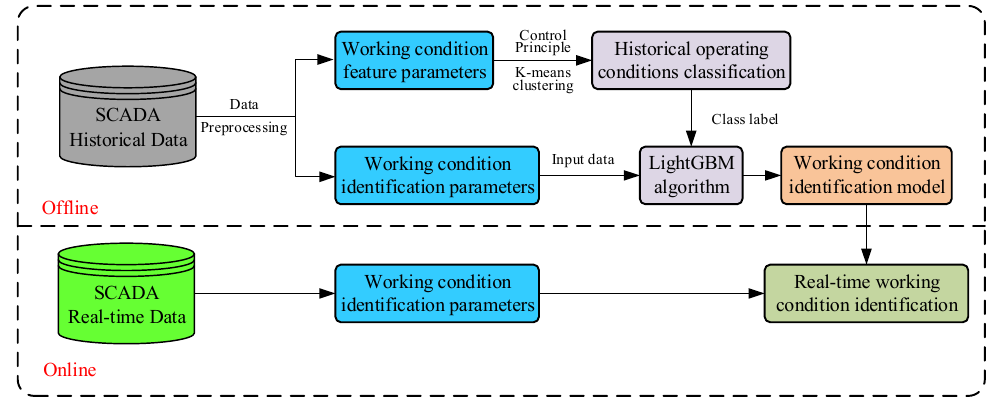
Figure 8. Flow chart of the work condition